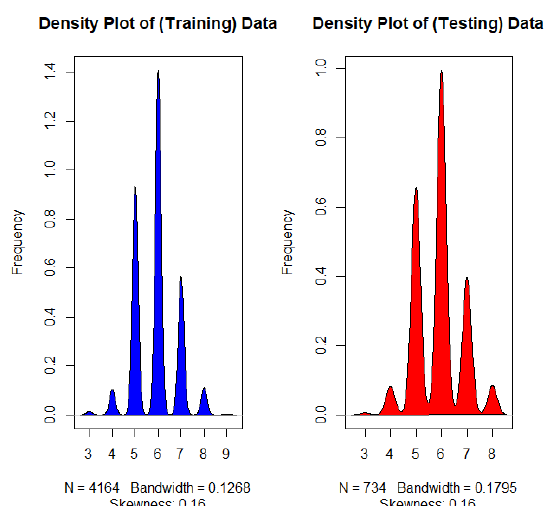
Figure 1. The density of Actual Data The above in Figure 1. is some summary stats and the distribution plot for wine quality. There are only seven levels of quality out of total ten, and they are following a close normal distribution.